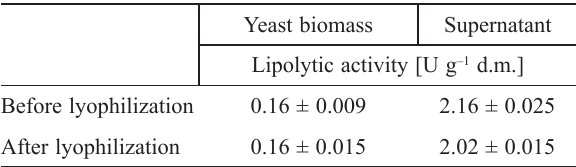
Table 2 – E ffect of lyophilization on Y. lipolytica lipase activ- ity synthesized during 40 h batch culture. Activity of the free supernatant translated from U mL –1 on U g –1 d.m. taking into account the percentage of dry matter equal to 2.7